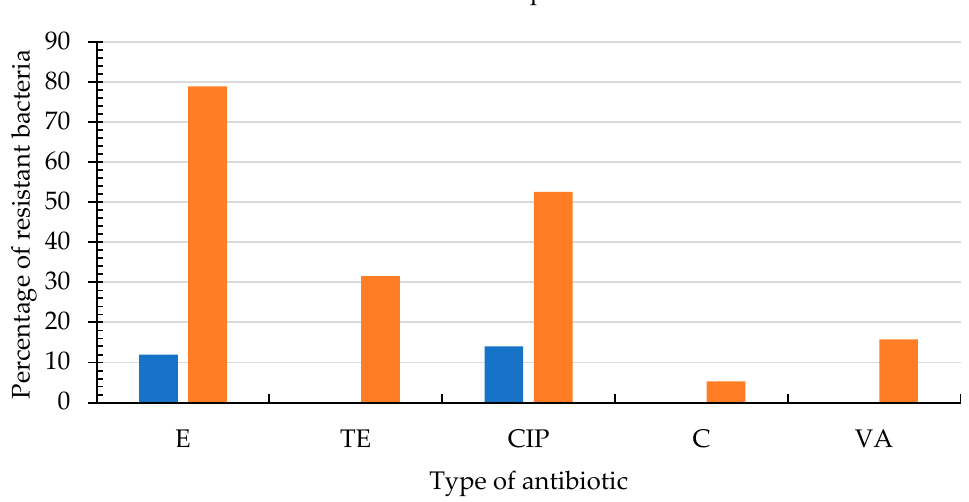
Figure 2. Percentages of resistant enterococci isolated from local ( n bacteria = 12) and imported ( n bacteria = 19) fresh produce for different antibiotics. CIP; ciprofloxacin (5 µ g), C; chloramphenicol (30 µ g), E; erythromycin (15 µ g), tetracycline (30 µ g), VA; vancomycin (256–0.015 µ g). Enterococci were susceptible to AMP; ampicillin (10 µ g), GM; gentamicin (500 µ g/mL), p ; penicillin (10 µ g), S; streptomycin (2000 µ g/mL) and did not hydrolyze nitrocefin (N). All enterococci produced negative results with nitrocefin indicating the absence of β - lactamase. The MIC of vancomycin ranged from 0.25 to 8 µ g/mL. No resistance to